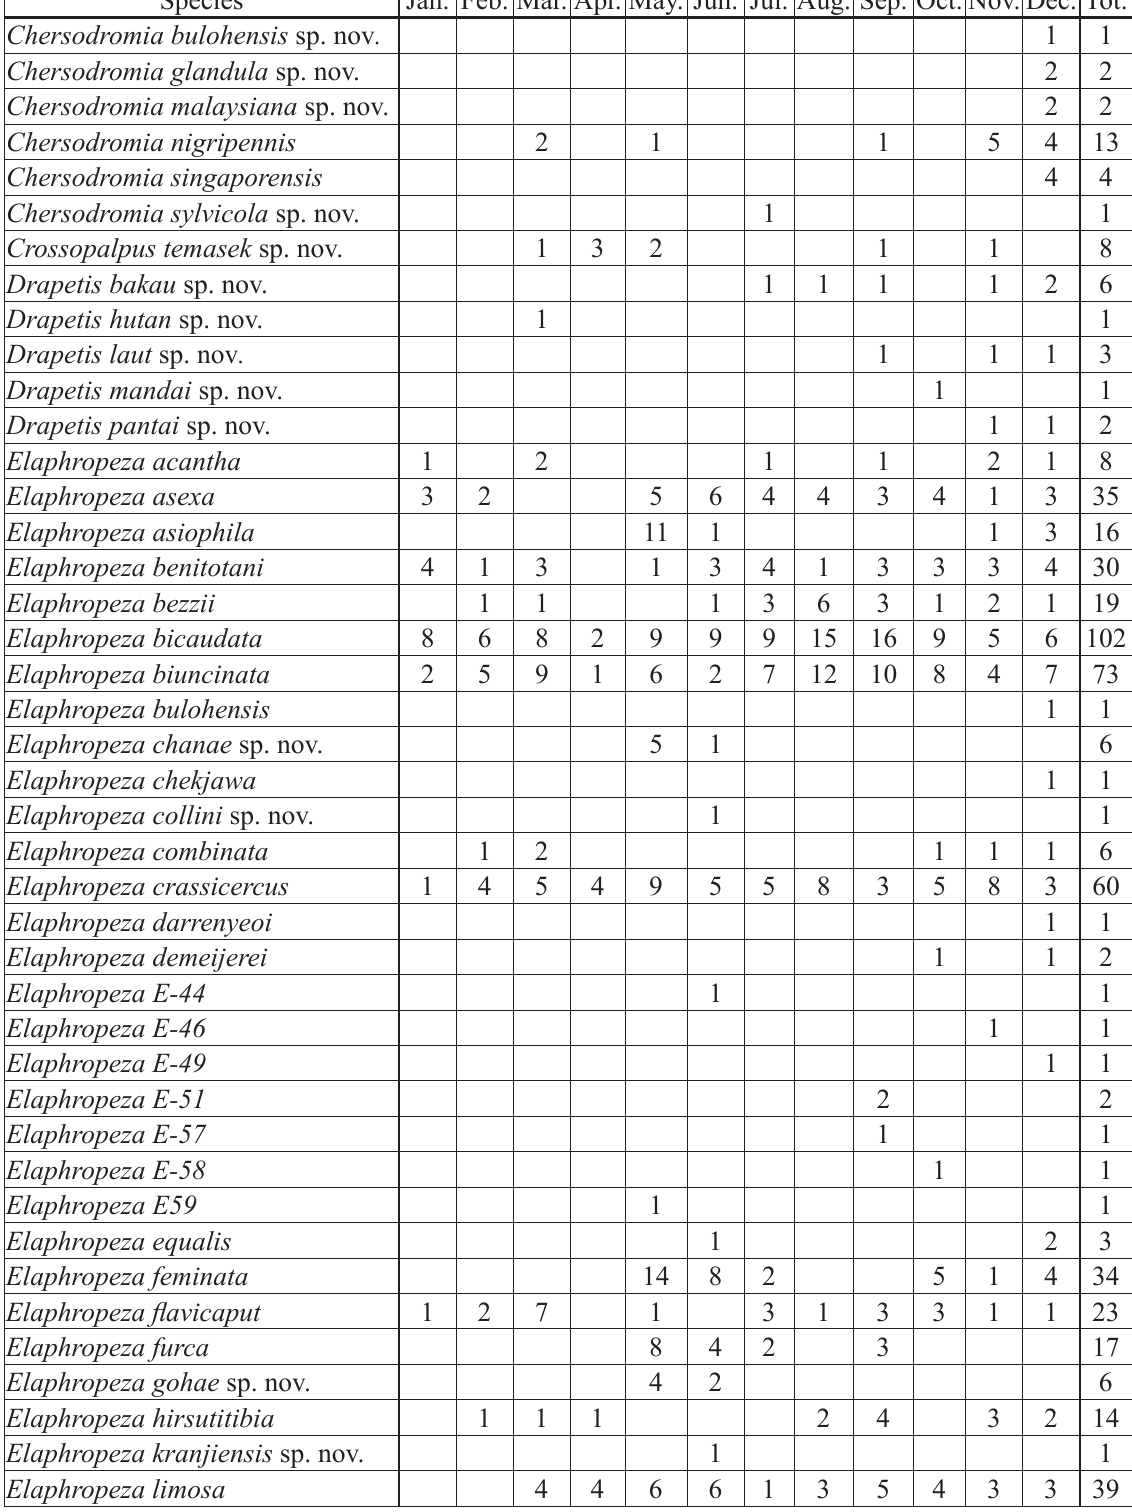
Table 1. Phenology of the Tachydromiinae in Singapore: figures represent the number of records (observation at a certain moment) not the number of